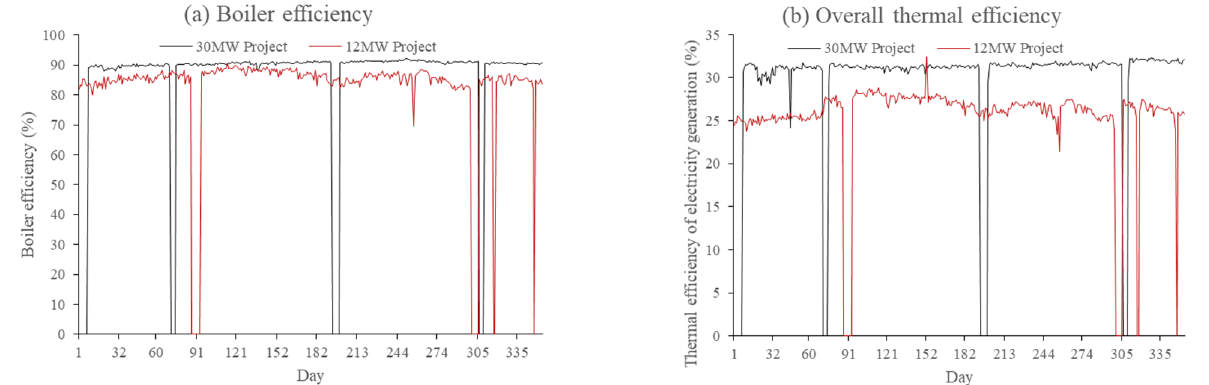
Figure 4. Boiler efficiency ( a ) and overall thermal efficiency ( b ). Table 2. Overall operation parameters in 2017.